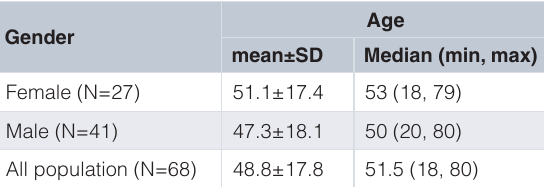
Table 2. Age distribution of our